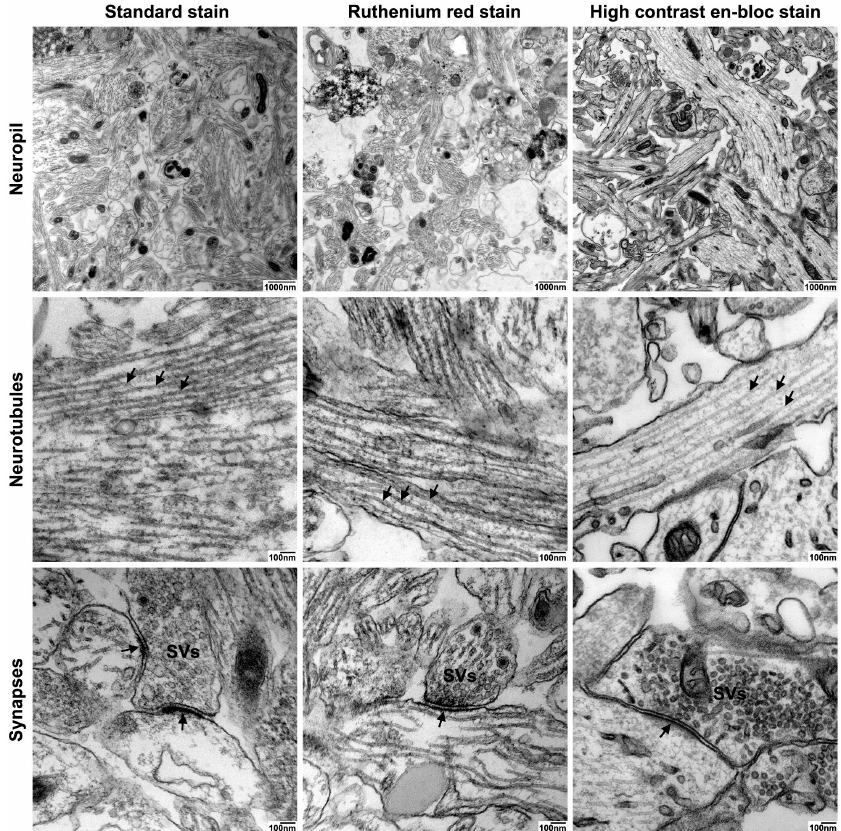
which resulted in intact and essentially parallel double membranes with clearly visible nuclear pores (arrowhead). N: nucleus, C: Cytoplasm. Scale bars: 100 nm. Panel 3: Rough endoplasmic reticulum. Optimal preservation and visualization of membranes of rough endoplasmic reticulum with flattened cisternae uniformly arranged in long profiles (arrowheads) after sample processing with high contrast en-bloc stain. Note that ribosomes are less visible after sample processing with high contrast en-bloc stain when compared to samples processed with standard stain or Ruthenium red stain. C: Cytoplasm. Scale bars: 250 nm. Panel 4: Golgi apparatus. Optimal preservation and visualization of golgi membranes with flattened cisternae uniformly arranged in long profiles and golgi vesicles after sample processing with high contrast en-bloc stain. C: Cytoplasm. Scale bars: 250 nm. Panel 5: Mitochondria (marked by asterisks). Optimal preservation and visualization of mitochondria with clearly visible outer double membrane, intact cristae, dense matrix, and mitochondrial granules after sample processing with high contrast en-bloc stain. Scale bars: 250 nm.